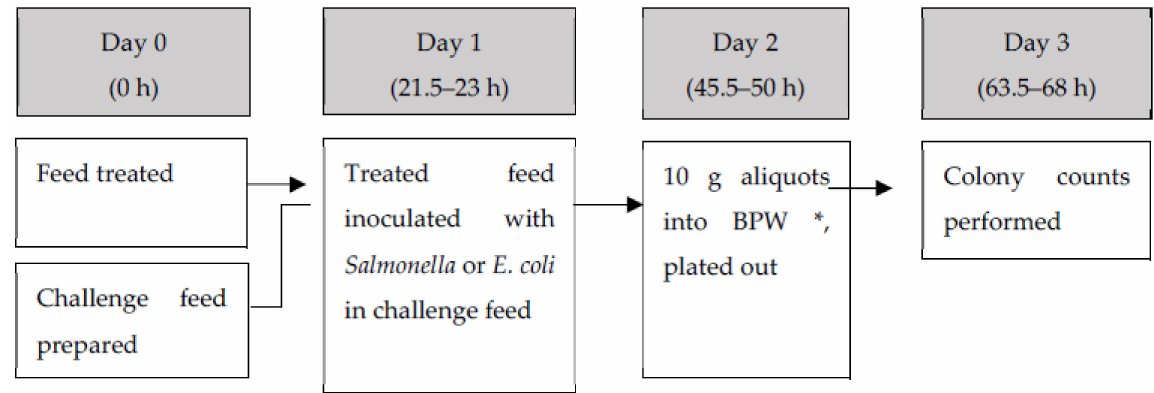
Figure 1. Diagrammatic breakdown of the testing method. * Buffered peptone